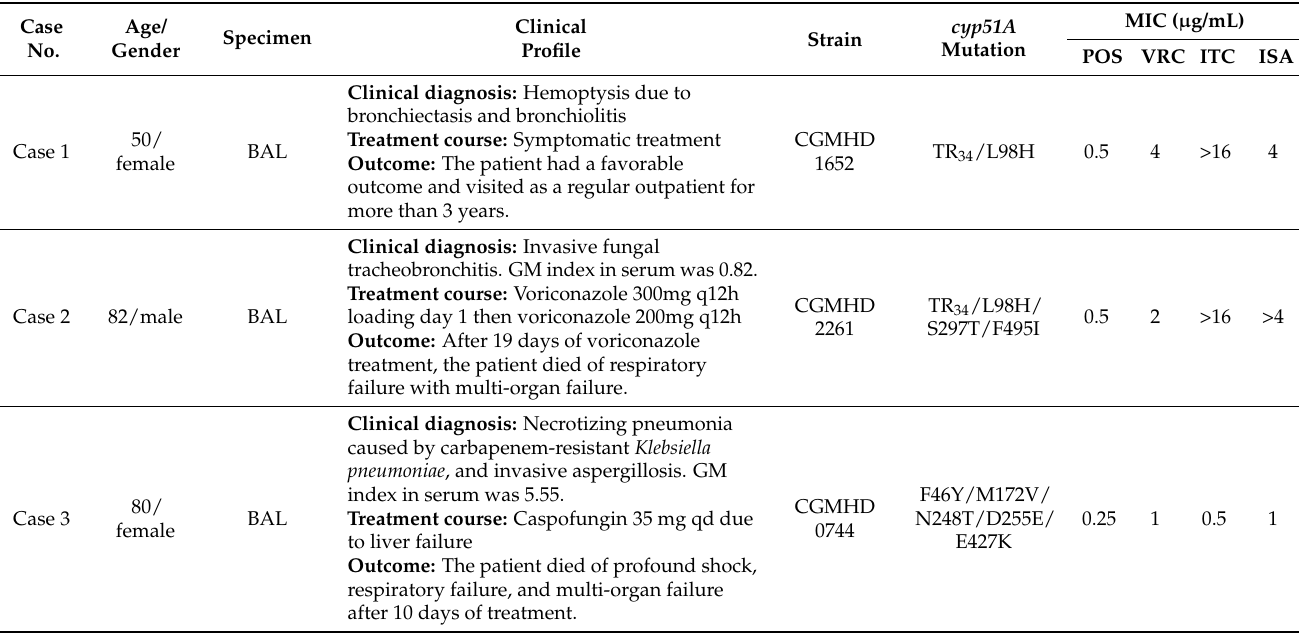
Table 3. The clinical profile of patients infected by resistant Aspergillus fumigatus and mycological characteristics of the